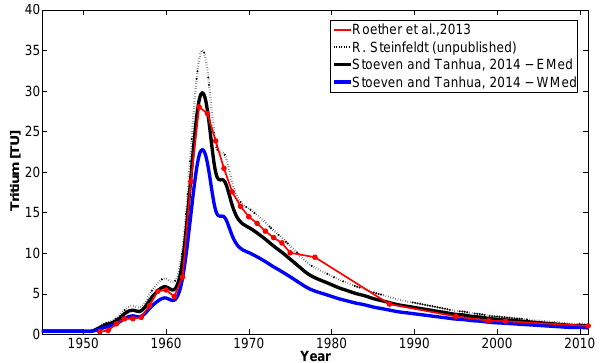
Figure 3. Input functions of tritium. The dotted black curve shows the decay based input function of the Mediterranean Sea by R. Steinfeldt (unpublished data). The black and blue curves describe the off set corrected input functions for the Eastern and Western Mediterranean Sea. The red curve shows the suggested input function by Roether et al. (2013) of the Eastern Mediterranean Sea.